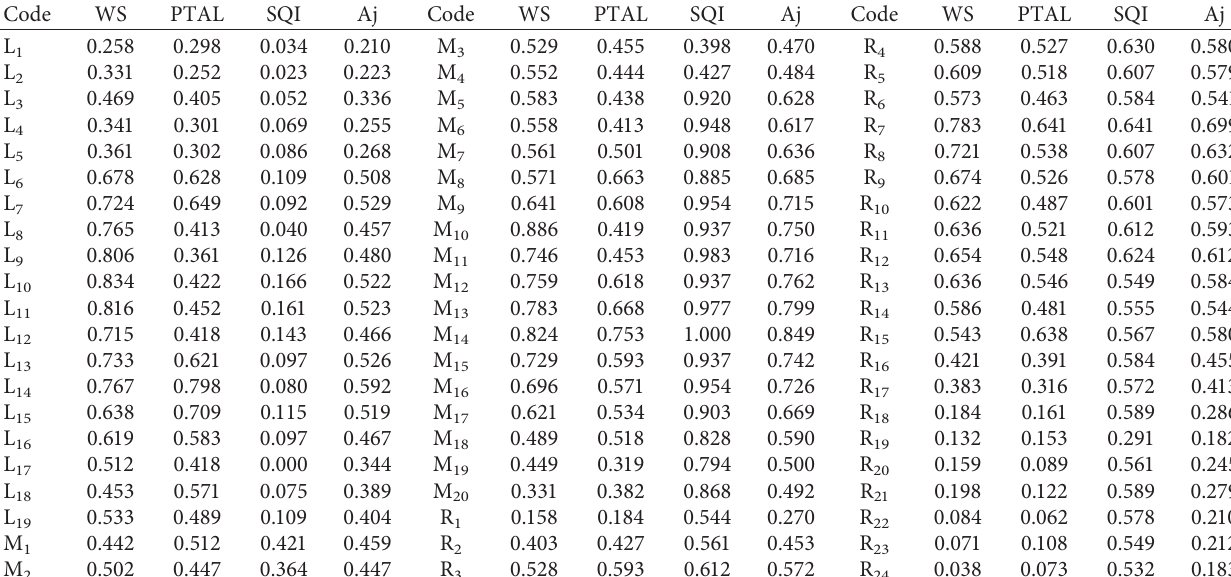
Table 2: The calculated variables of models.